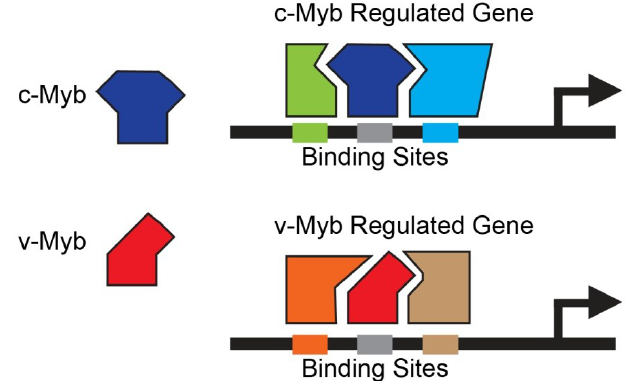
but differences in protein-protein interactions stabilize the two Myb proteins on different sets of